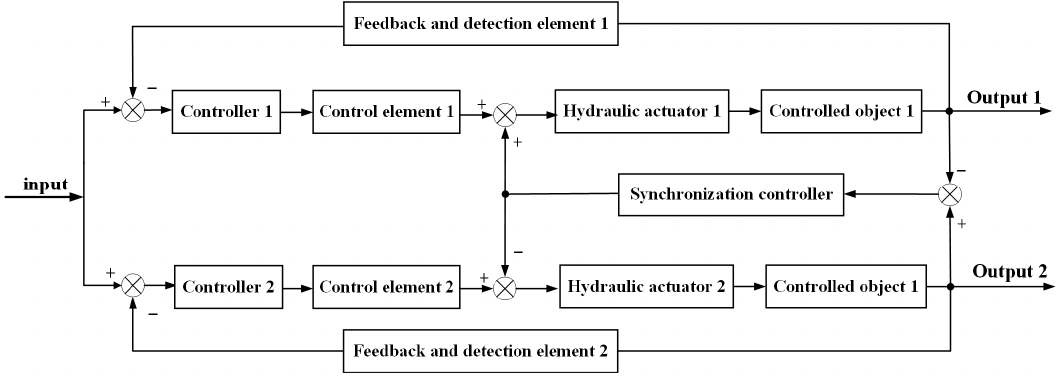
Figure 4. Cross-coupling control block diagram of hydraulic synchronous control system.